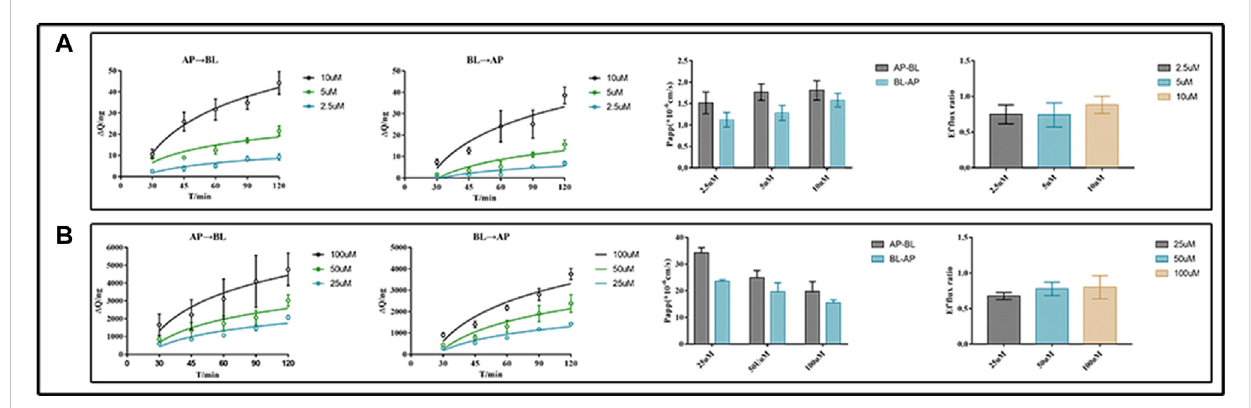
FIGURE 2 Transmembrane transport studies of evodiamine (EDM) and dehydroevodiamine (DEDM). CaCo-2 cells were cultured in transwell plate for 21 days toformCaco-2monolayers.TheEDM(2.5,5,and10 μ M)andDEDM(25,50,and100 μ M)wereaddedtothedonorsideandtheHBSSmediumwasplaced in the receiver chamber. The sample was collected at 0, 30, 45, 60, 90, and 120 min from each receiver chamber. High-performance liquid chromatography (HPLC) was used to analyze samples and assess the ef fl ux ratio (ER) and calculate apparent permeability coef fi cients (P app ). The accumulation and P app of drugs across AP → BL and BL → AP, as well as the ef fl ux ratio of drugs, are shown from left to right. (A) EDM; (B) DEDM. Data are shown as the mean ± SD ( n =